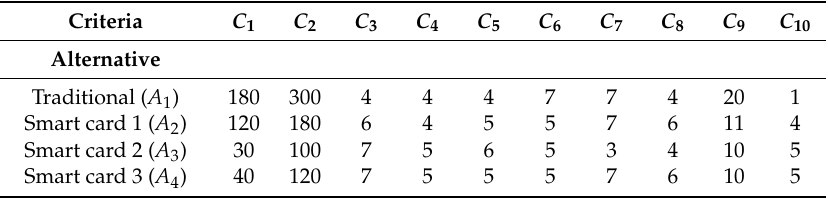
Table A2. Initial decision matrix filled by DM2 for WASPAS analysis.